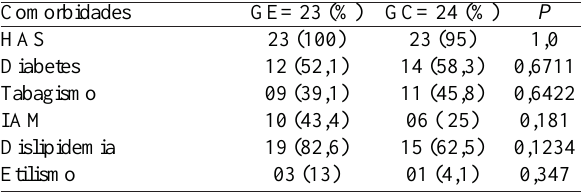
Tabela 2. Comorbidades da população estudada.